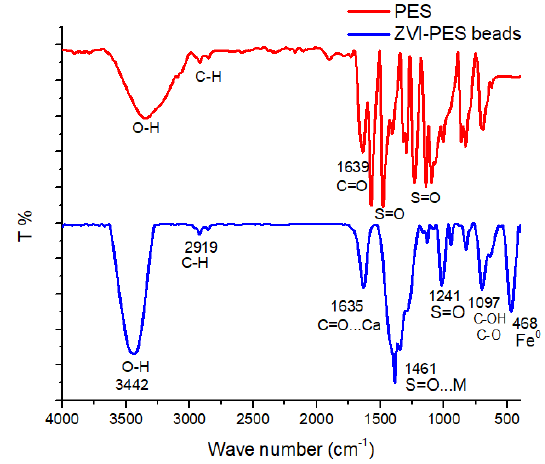
Figure 2. FTIR spectra of PES and PES/ZVI beads.